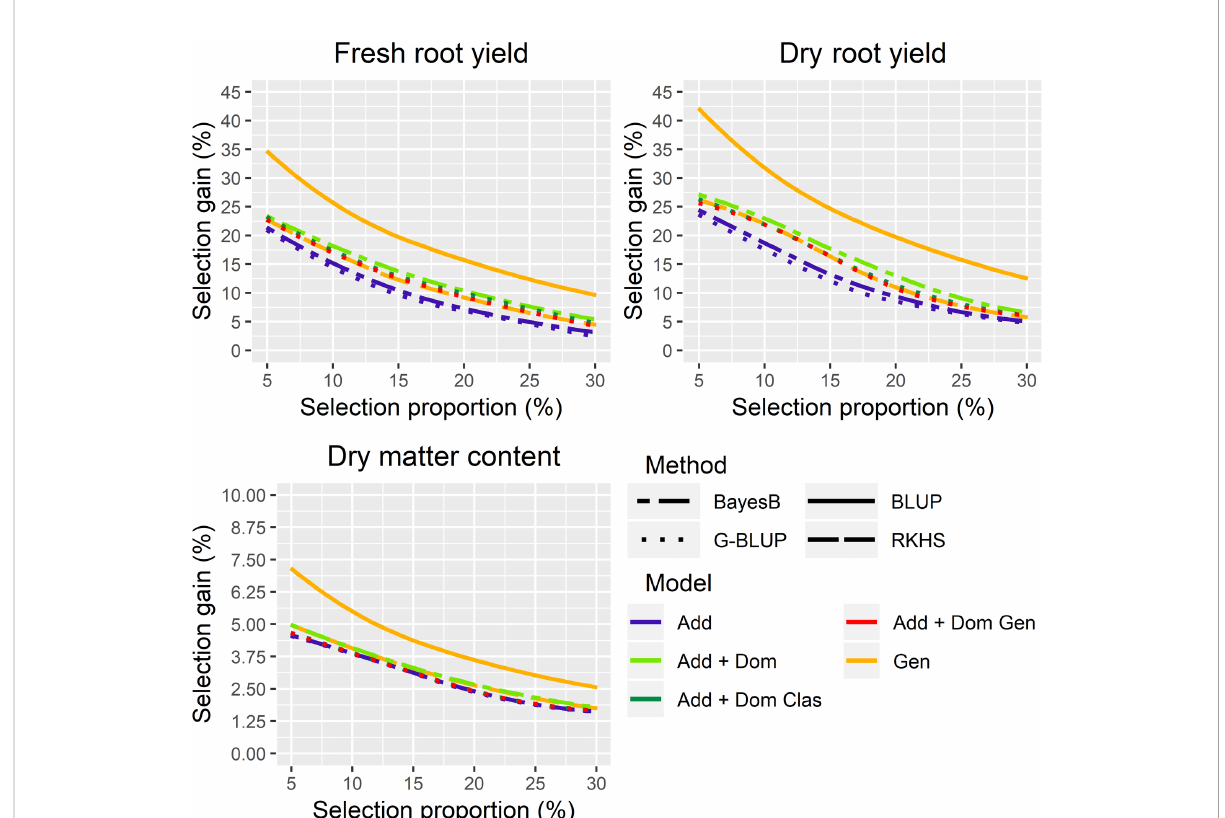
FIGURE 2 Expected selection gains for combinations of different genomic prediction methods and genetic models for fresh (FRY) and dry root yield (DRY) and dry matter content (DMC) in the roots of cassava, considering a selection proportion ranging from 5 to 30%. G-BLUP: genomic best linear unbiased prediction method; BLUP: phenotypic best linear unbiased prediction method; RKHS: reproducing kernel Hilbert spaces method; Add: additive; Add + Dom, Additive and dominant genetic model; Add + Dom Clas, Additive and dominant classical genetic model; Add + Dom Gen, Additive and dominant genotypic genetic model; Gen, genotypic